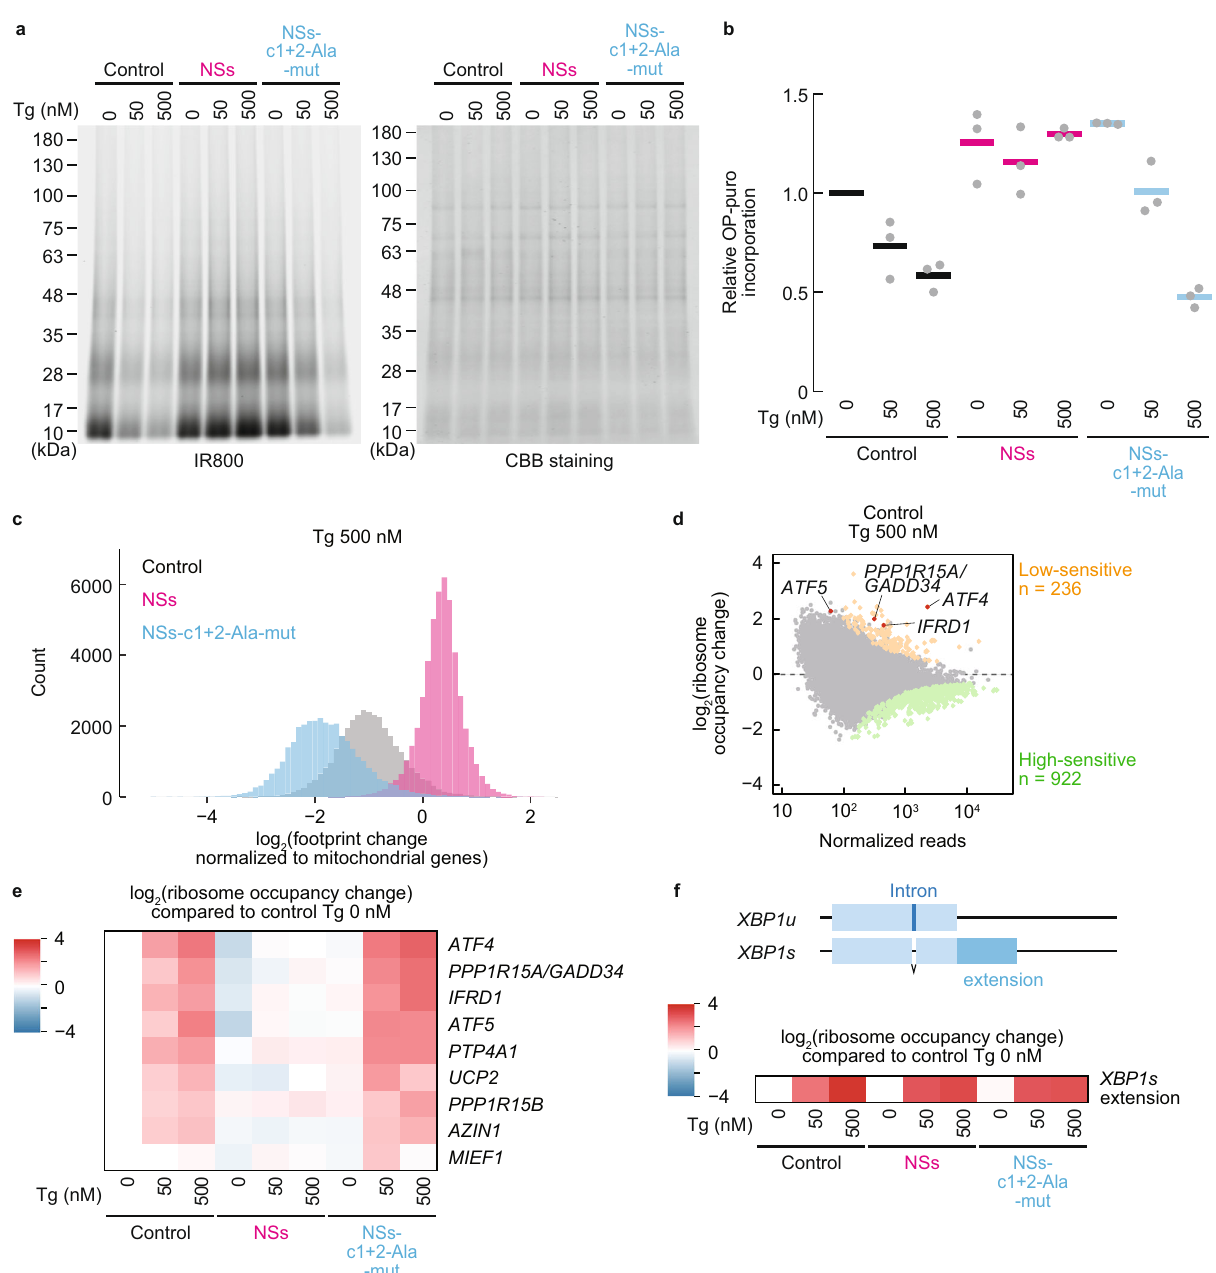
Fig. 4 SFSV NSs suppresses translational impacts induced by thapsigargin. a Global protein synthesis rate measured by OP-puro labeling in control, SFSV NSs-expressing, or SFSV NSs-c1 + 2-Ala-mut-expressing cells. Cells were also treated with 50 or 500 nM Tg. Representative images of three biologically independent replicates of labeled nascent proteins (IR800 signal) and total protein with Coomassie Brilliant Blue (CBB) staining are shown. b Quanti fi cation of nascent proteins labeled with OP-puro, normalized by total protein in ( a ). Data of three replicates (points) and the means (bars) are shown. c Histogram of the number of transcripts along the footprint change in cells treated with 500 nM Tg. Data were normalized to the mean of footprint change of mitochondrial genome-encoded genes (used as internal spike-ins). Bin width is 0.1. d MA (M, log ratio; A, mean average) plot of the ribosome occupancy change in control vector-transfected cells treated with 500 nM Tg. High-sensitive and low-sensitive mRNAs (de fi ned as false discovery rate [FDR] < 0.05) are highlighted. e , f Heatmap of ribosome occupancy changes on uORF-containing stress-resistant mRNAs (identi fi ed in ref. 28 ) ( e ) and XBP1s extension ( f ), compared to control vector-transfected cells treated with 0 nM Tg. The log 2 -fold change scales are shown at the color bars. Schematic representations of the XBP1 gene are shown on the top of f . The intron in the XBP1u mRNA is spliced to produce the C-terminally extended protein upon ER stress. Source data are provided as a Source Data fi